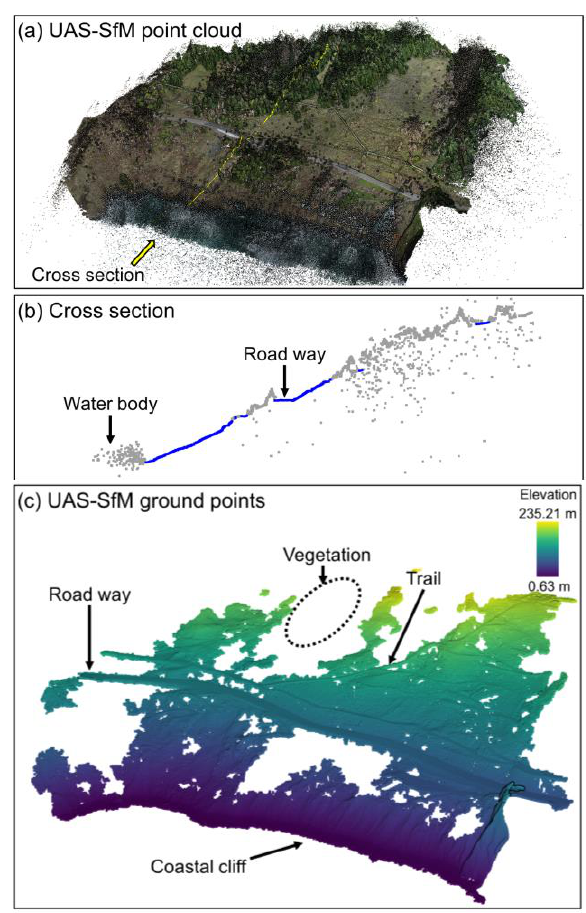
Figure 10 Vo-SmoG result ( VS Ground = 0.3 m) for the UAS-SfM point